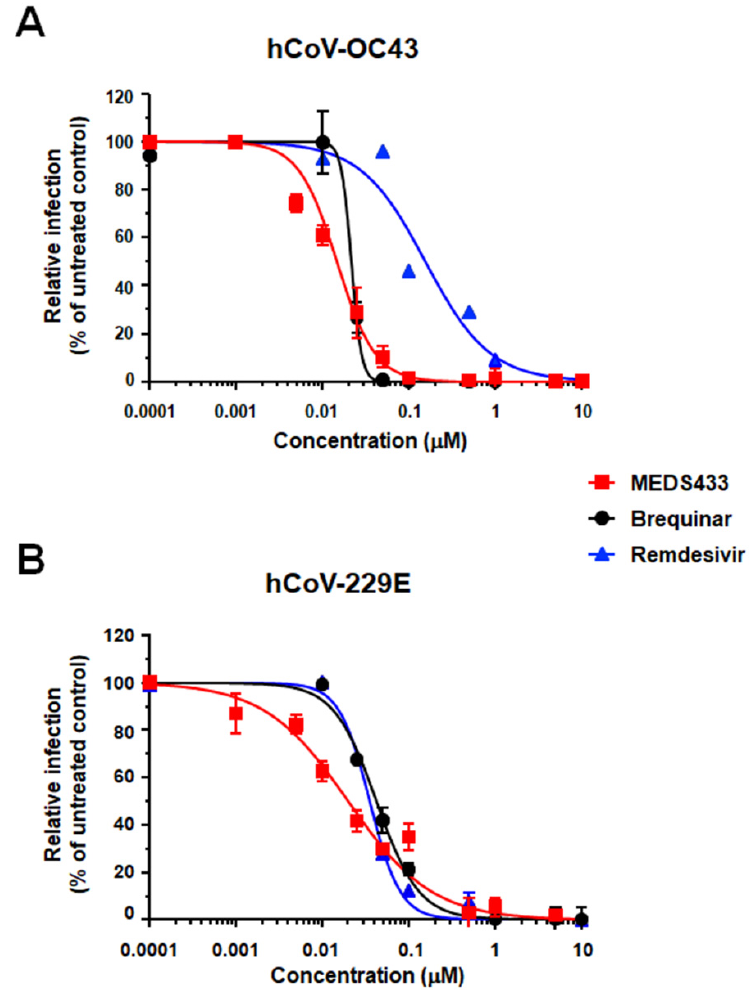
Figure 2. Antiviral activity of MEDS433 against hCoV-OC43 and hCoV-229E. HCT-8 ( A ) or MRC5 ( B ) cell monolayers were infected with the hCoV-OC43 or hCoV-229E (100 PFU/well), and, where indicated, the cells were treated with increasing concentrations of compounds 1 h before, and during virus adsorption. Compounds remained in the culture medium throughout the experiment. hCoV-OC43 replication was quantified at 72 h p.i. by FFRA, while for hCoV-229E, MRC5 cell viability was measured using the CellTiter-Glo luminescent at 72 h p.i. as a surrogate of viral CPE. The compounds concentrations producing 50% and 90% reductions of viral replication (EC 50 and EC 90 , respectively) were determined by GraphPad Prism. The data shown represent means ± SD (error bars) of three independent experiments performed in triplicate.